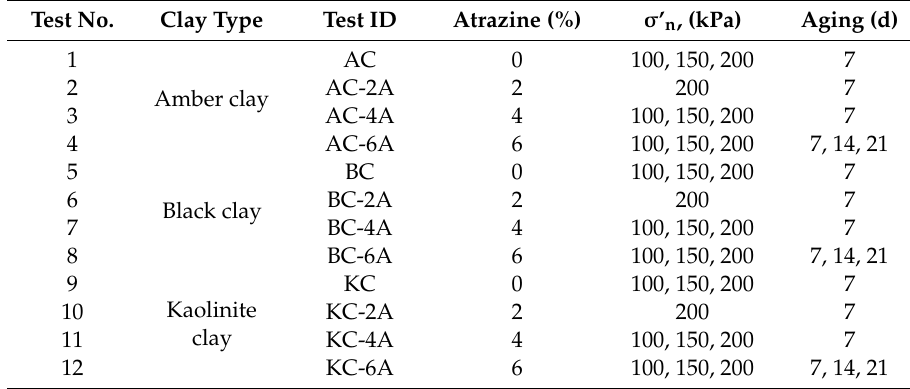
Figure 4. (a) Torsional ring shear used to perform shear strength tests (b) amber clay specimen; (c) Figure 4. ( a ) Torsional ring shear used to perform shear strength tests ( b ) amber clay specimen; ( c ) black black clay; (d) a kaolinite clay specimen. clay; ( d ) a kaolinite clay specimen. Table 2. A summary of the designed tests in this